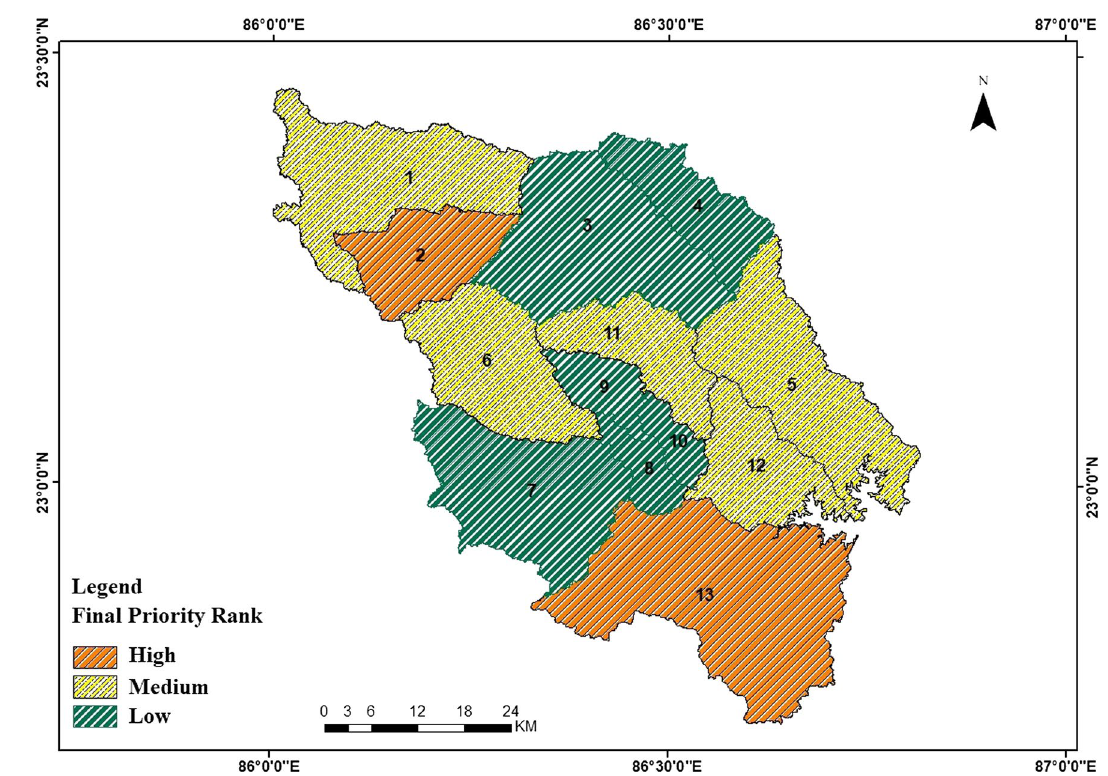
Fig. 9 Sub-basin-wise final composite prioritization in Kansai–Kumari reservoir catchment